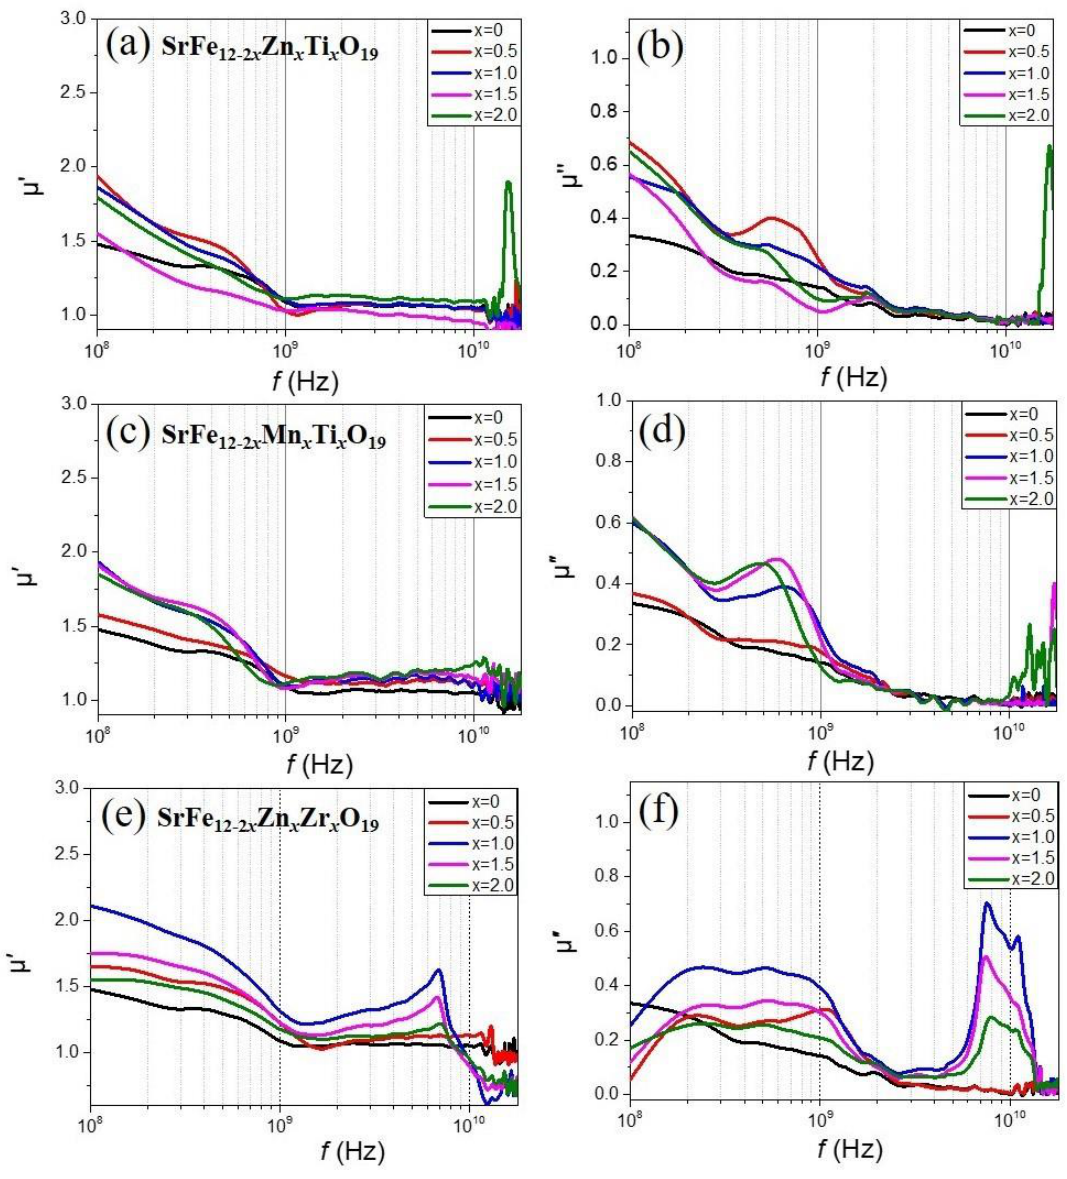
Figure 3. Real and imaginary part of permittivity ( µ (cid:48) and µ (cid:48)(cid:48) ) spectra (0.1 ≤ f ≤ 18 GHz) of the hexaferrites, ( a , b ) SrFe 12 − 2x Zn x Ti x O 19 , ( c , d ) SrFe 12 − 2x Mn x Ti x O 19 , ( e , f ) SrFe 12 − 2x Zn x Zr x O 19 ( x = 0, 0.5, 1.0, 1.5, 2.0) powder-epoxy (10 wt%)